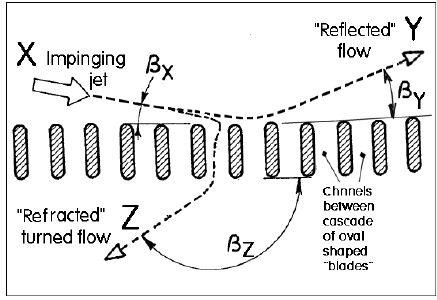
Fig. 5. The splitting of the impinging wall from X into the two outflow components, the reflected Y and refracted Z . The angles, especially  Z , vary substantially with varying Reynolds numbers.